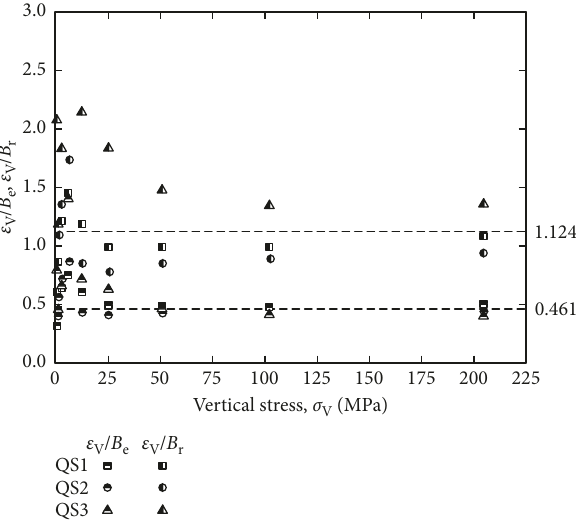
Figure 13: Relationship between σ